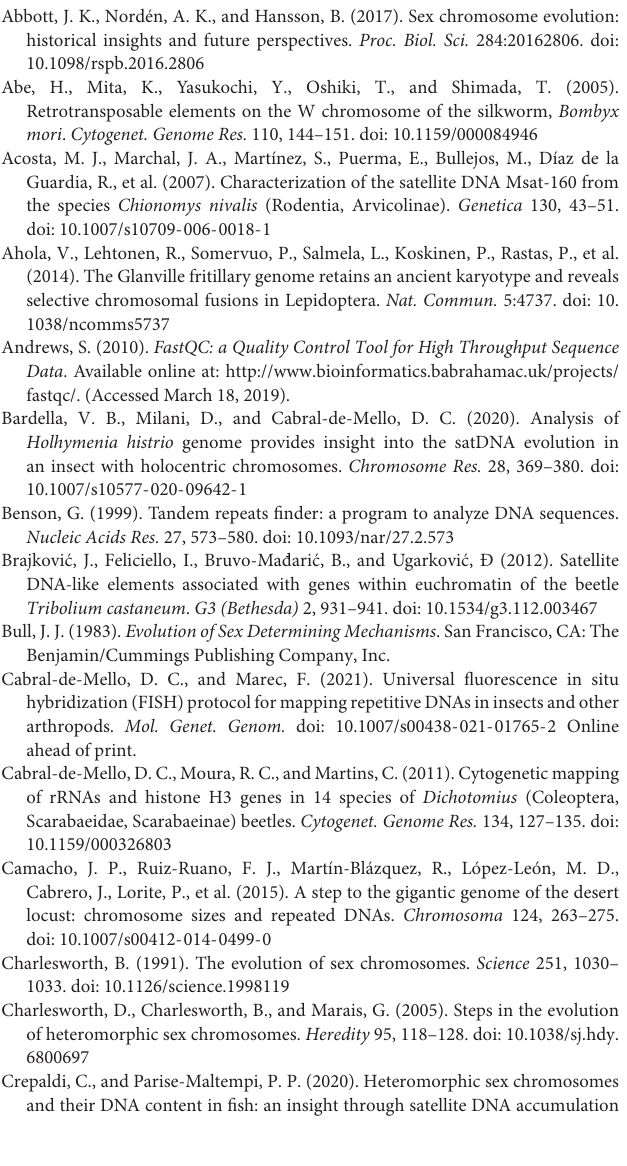
Supplementary Figure 1 | Mitotic chromosome spreads obtained from wing imaginal disks of female larvae of (A) Cydalima perspectalis (prometaphase) and (B) Diatraea postlineella (early anaphase) and stained with DAPI. Bar = 10 µ m. Supplementary Figure 2 | DAPI-stained pachytene bivalents obtained from testes (top images). (A) Cydalima perspectalis ( n = 31), (B) Diatraea postlineella ( n = 21) and (C) Ostrinia nubilalis ( n = 31). A schematic drawing of the same representation was used to determine the number of bivalents. Bar = 10 µ m.